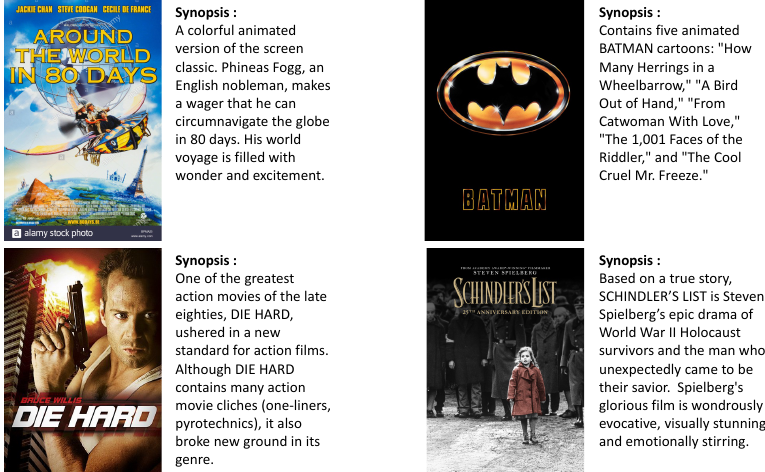
Figure 4. Examples of providing synopsis information ( Yahoo